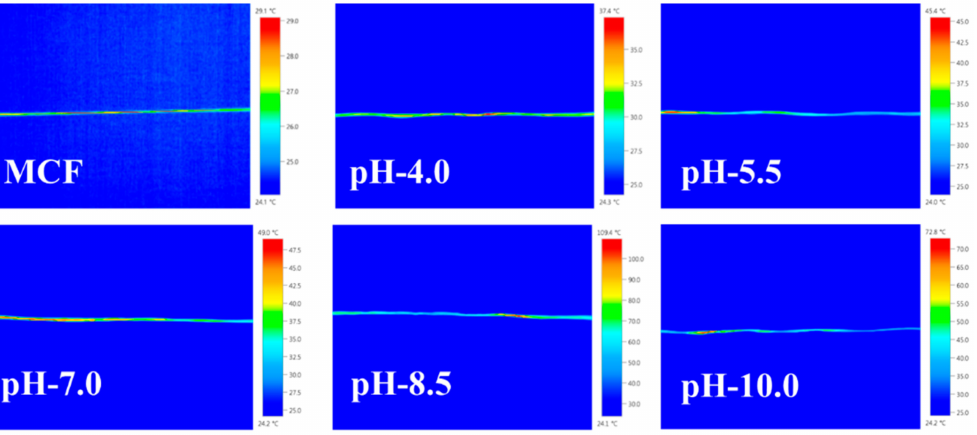
Figure 10. Thermo-graphic camera images of MCF as a function of the pH of the plating